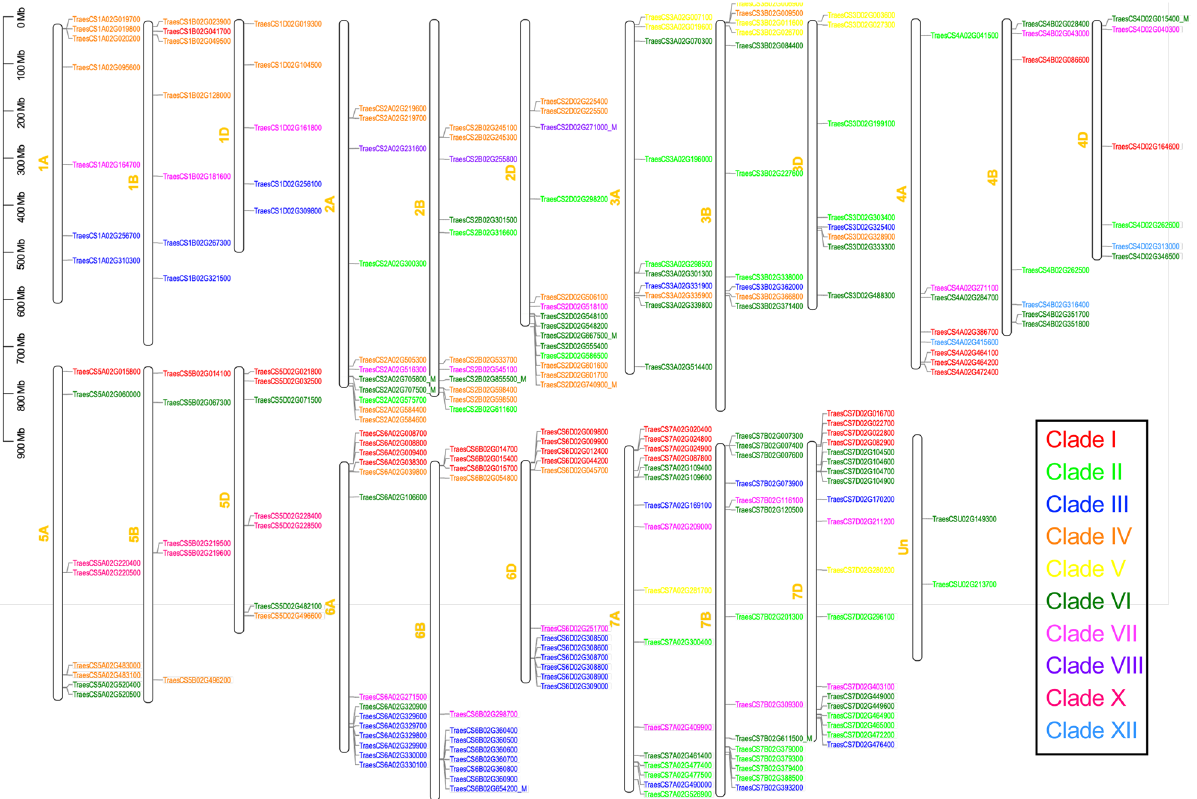
Figure 2. Chromosomal locations of TaUMAMIT genes. The gene IDs are color coded by the clades as indicated in the inset. Low confidence genes identified in this study are indicated with _M. Un represents the unassigned